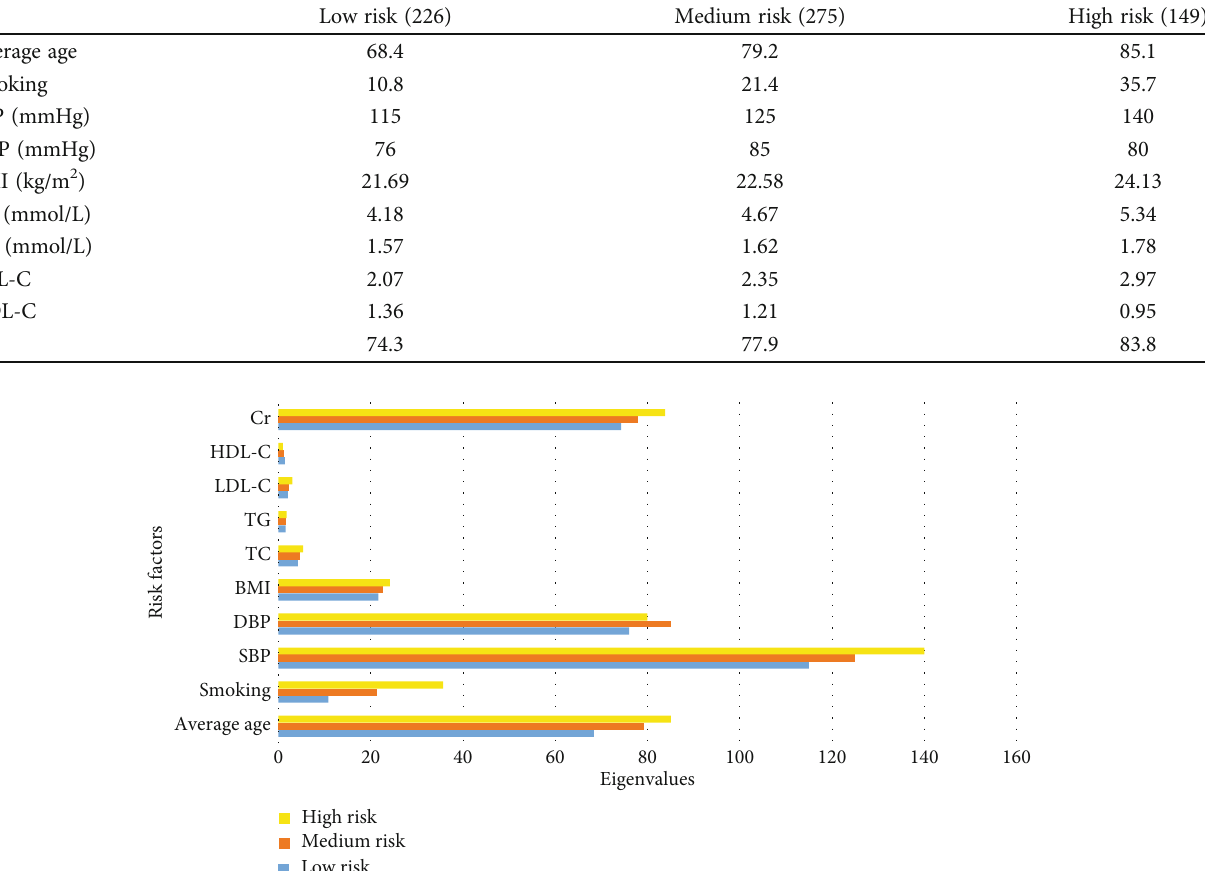
Table 3: Clinical baseline characteristics of study